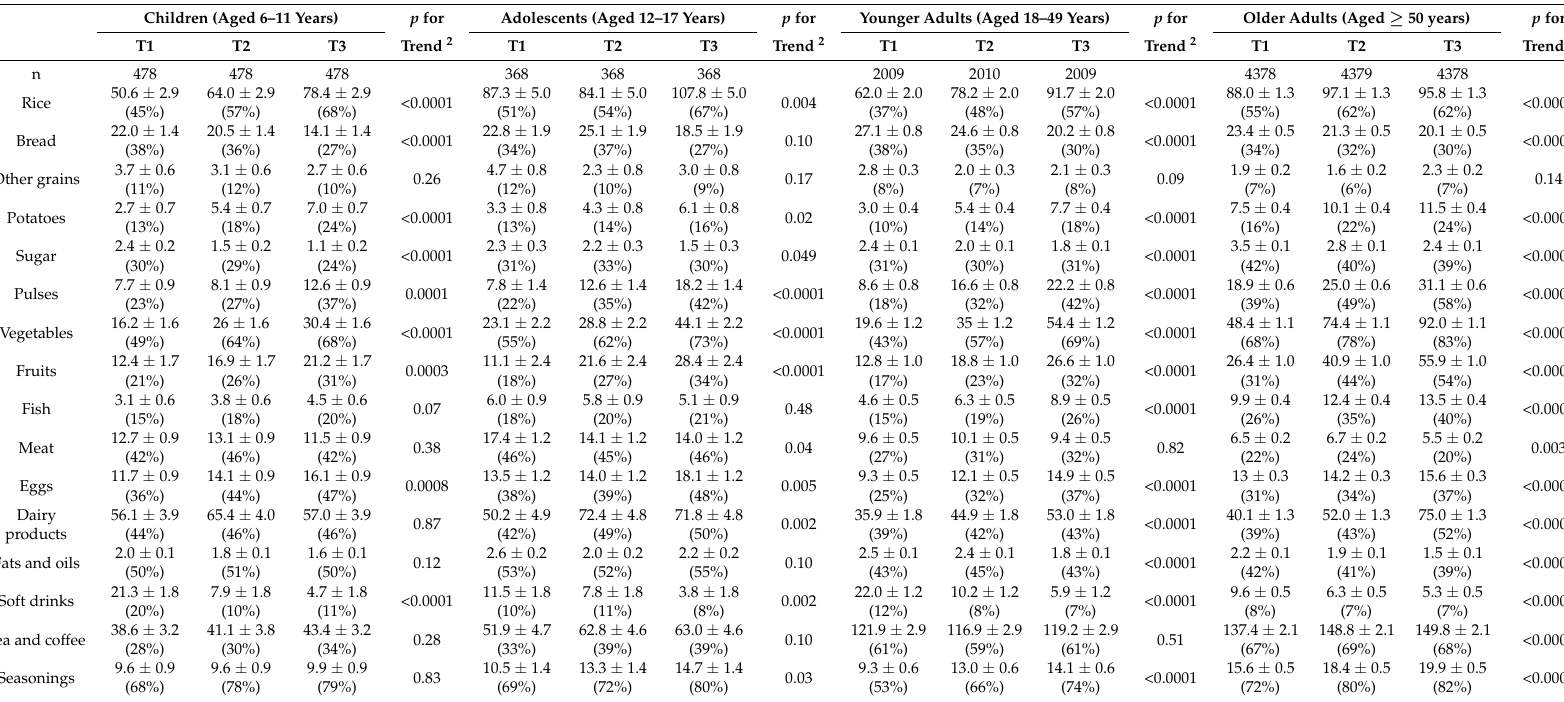
Table 4. Intakes of food groups at breakfast (in grams) among breakfast consumers according to tertile (T) category of the Nutrient-Rich Food Index 9.3 (NRF9.3) score as a measure of overall diet quality 1